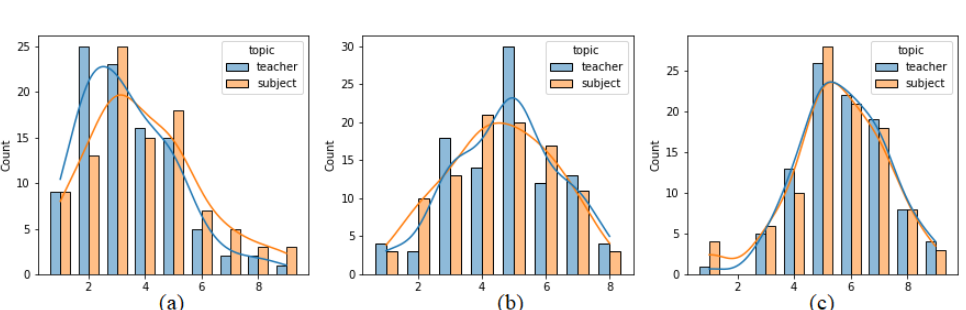
Figure 4. Distribution of ( a ) pleasure, ( b ) arousal and ( c ) dominance values, separately for positive and negative opinions.